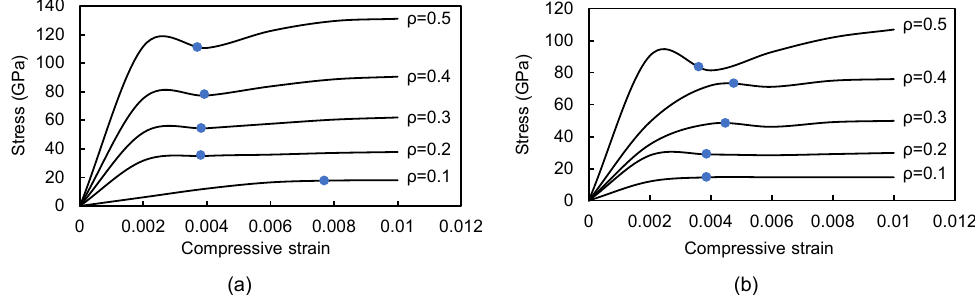
Figure 4. Overall compressive stress-strain curves of np-Au I ( a ) and np-Au II ( b ). The 0.2% offset stress is indicated on the curves by filled